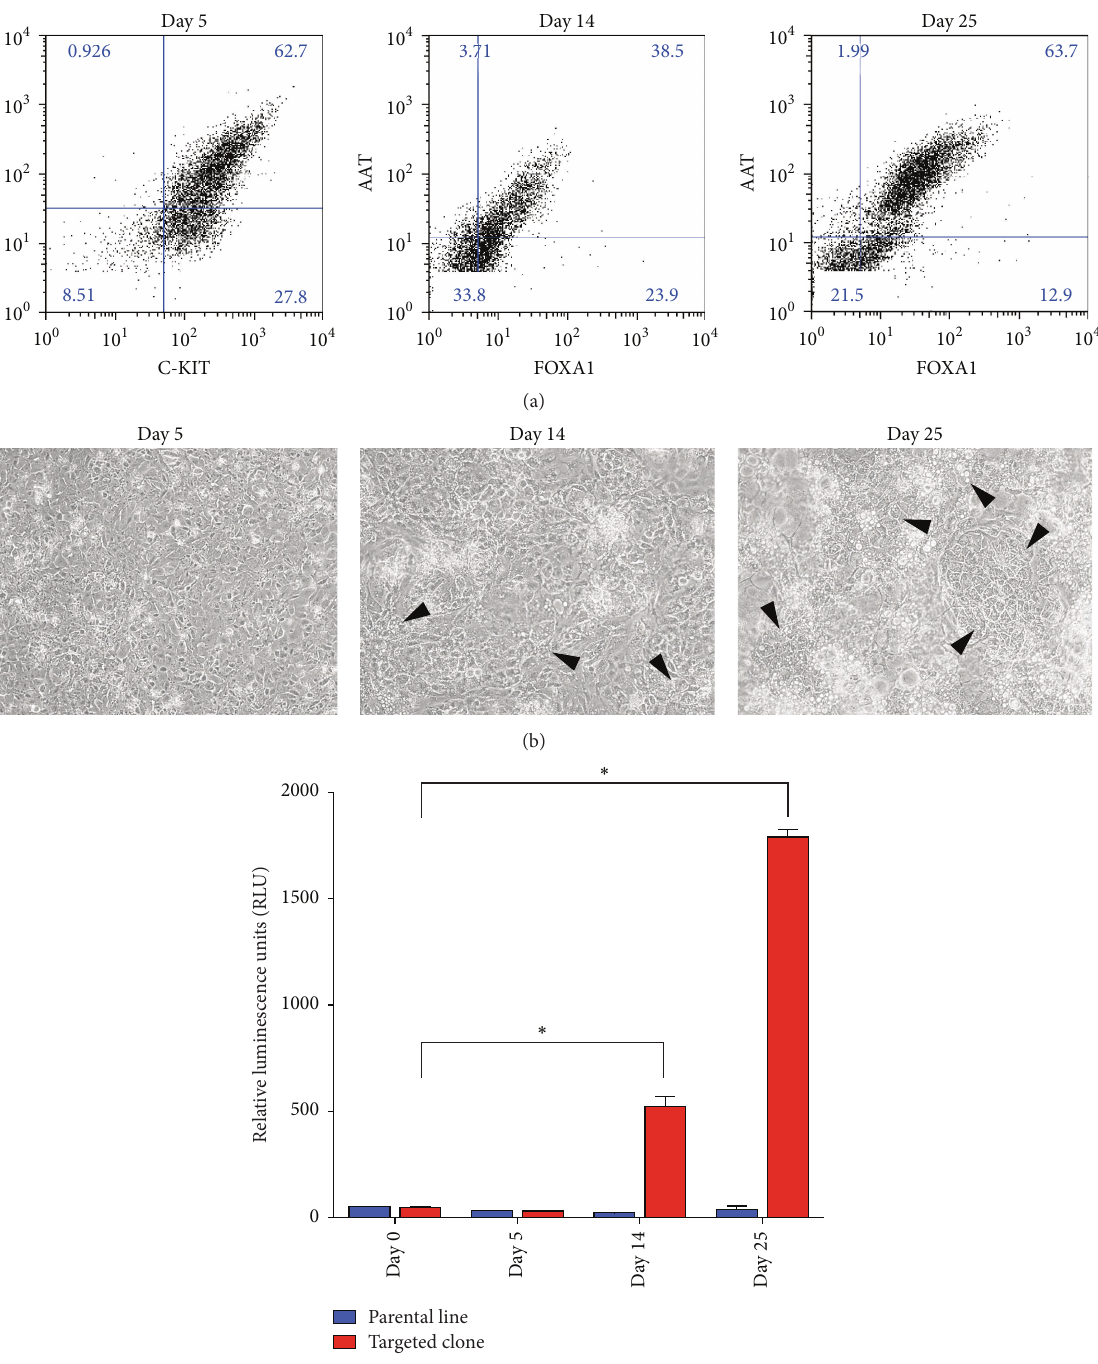
Figure 2: Hepatocyte specification yields luciferase expression in cells derived from CYP1A1 reporter iPSCs . (a) iPSCs were differentiated towards CXCR4+/C-KIT+ definitive endoderm (day 5) followed by FOXA1+/AAT+ hepatic progenitors (day 14) that grew in number and were the majority of the culture by day 25. (b) Micrographs show homogenous morphology of definitive endoderm cultures (day 5), but by day 14, hepatic-like cells begin to emerge (denoted by black arrowheads) and are observed more frequently by day 25. (c) Concomitant with hepatic specification, luciferase levels significantly increase ( 𝑁 = 3 , ∗ 𝑃 < 0.0005 , Student’s 𝑡